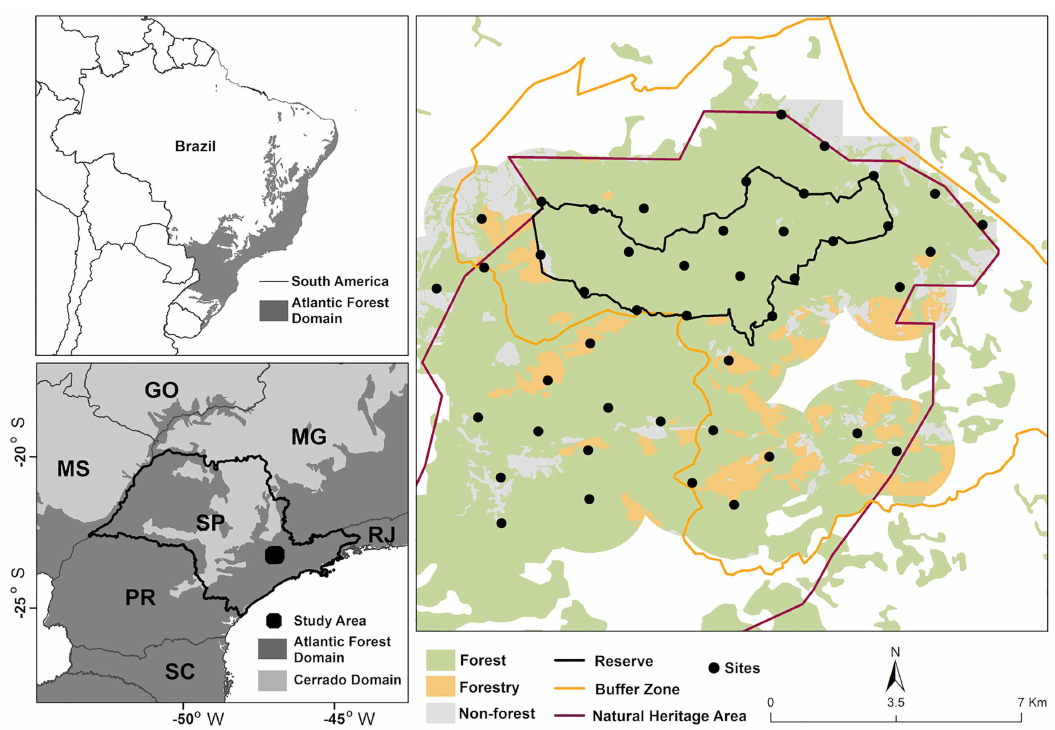
Fig 1. Study area. Study area and the samplingsites’ locationsat Serra do Japi (Brazil) where Neotropical spotted cats were sampledusing camera trap and scat sampling.